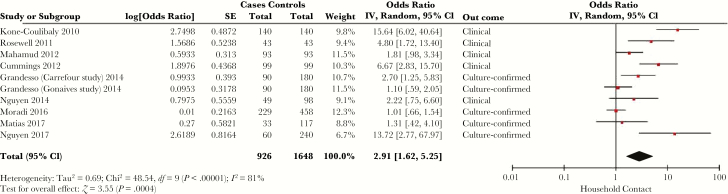
Forest plot of studies included in meta-analysis assessing whether presence of a household contact with cholera was associated with symptomatic cholera. The summary odds ratio was calculated using random effects models. Heterogeneity is described using the Cochran Q test and the I2 statistic. Abbreviations: CI, confidence interval; df, degrees of freedom; IV, inverse variance; SE, standard error.